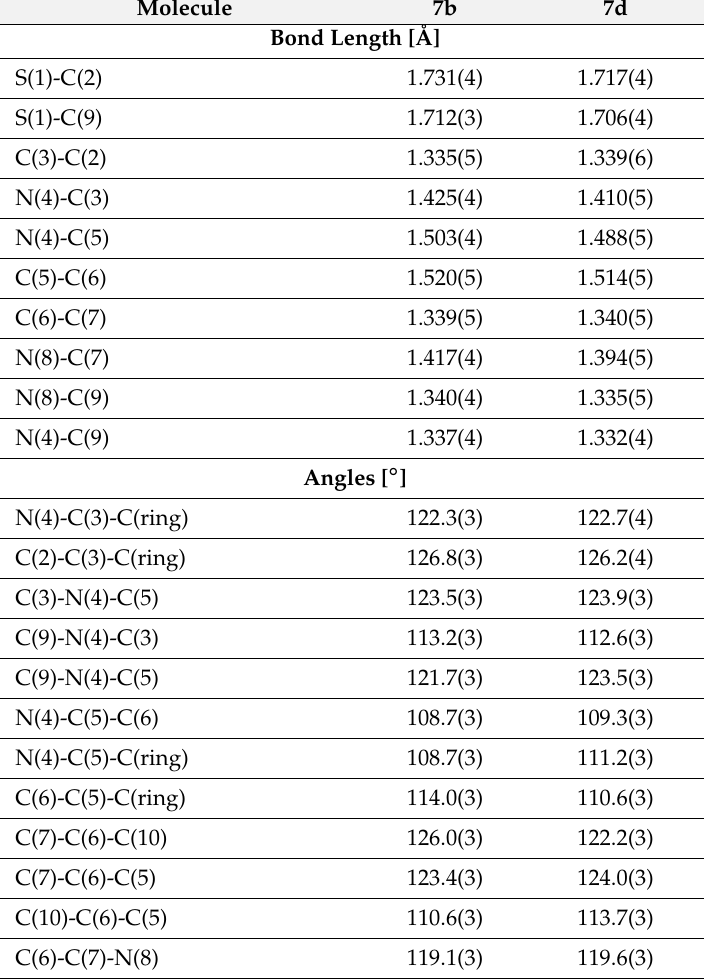
Table 4. Selected geometrical parameters for compounds 7b and 7d.